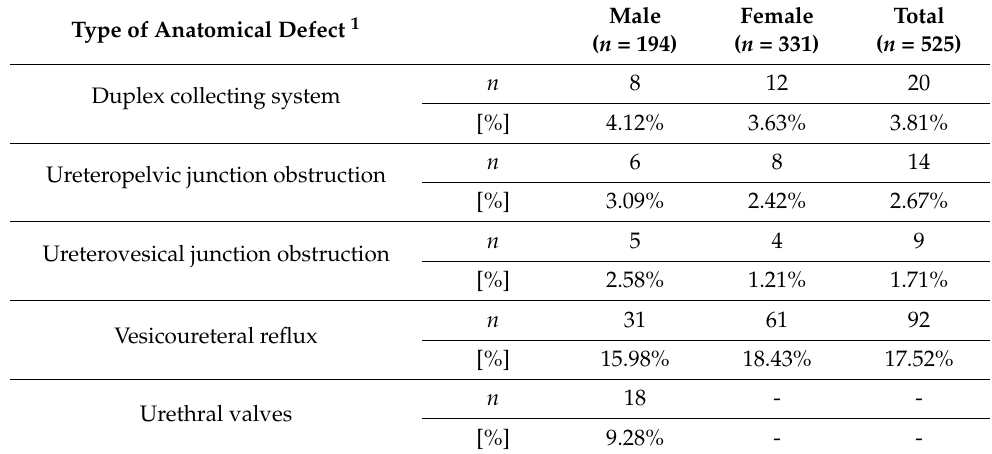
Table 2. Anatomical defects of urinary tract depending on gender of patients.